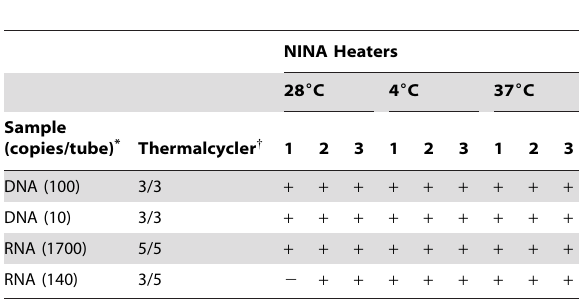
efficiency and reproducibility in NINA heaters.